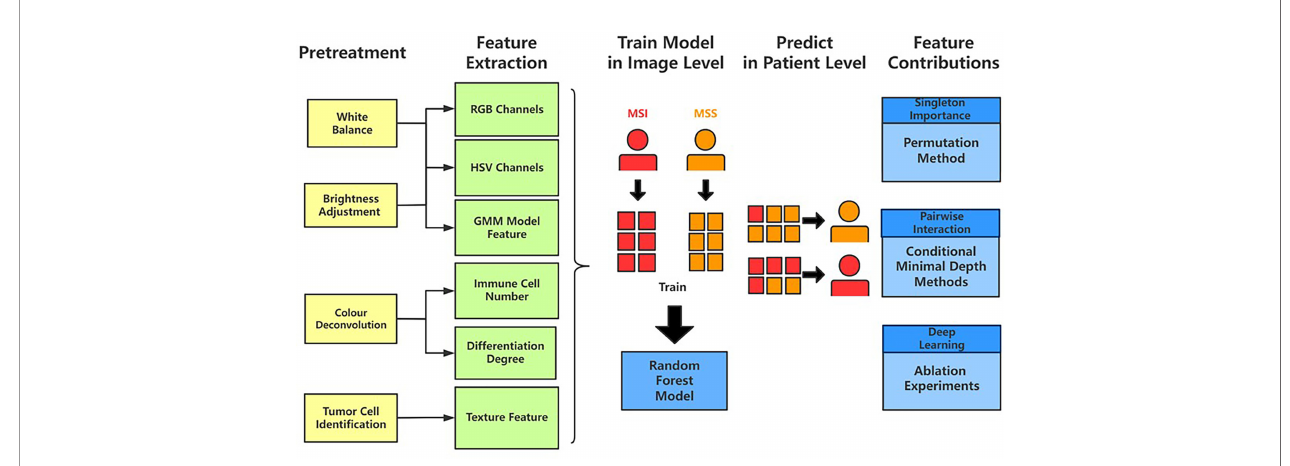
FIGURE 2 | The work fl ow of studying pathological features in discriminating against MSI from MSS. Five main steps — pretreatments, feature extraction, model training, patient-level predictions, and feature contributions analysis — were sequentially executed to improve image quality, generate pathological features, build statistical model, evaluate model performance, and measure features ’ contributions,